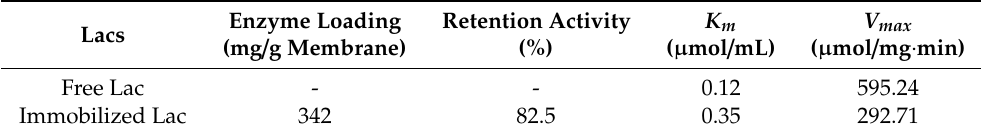
Table 1. Enzyme loading, retention activity and kinetic parameters of the free and immobilized laccase (Lac).